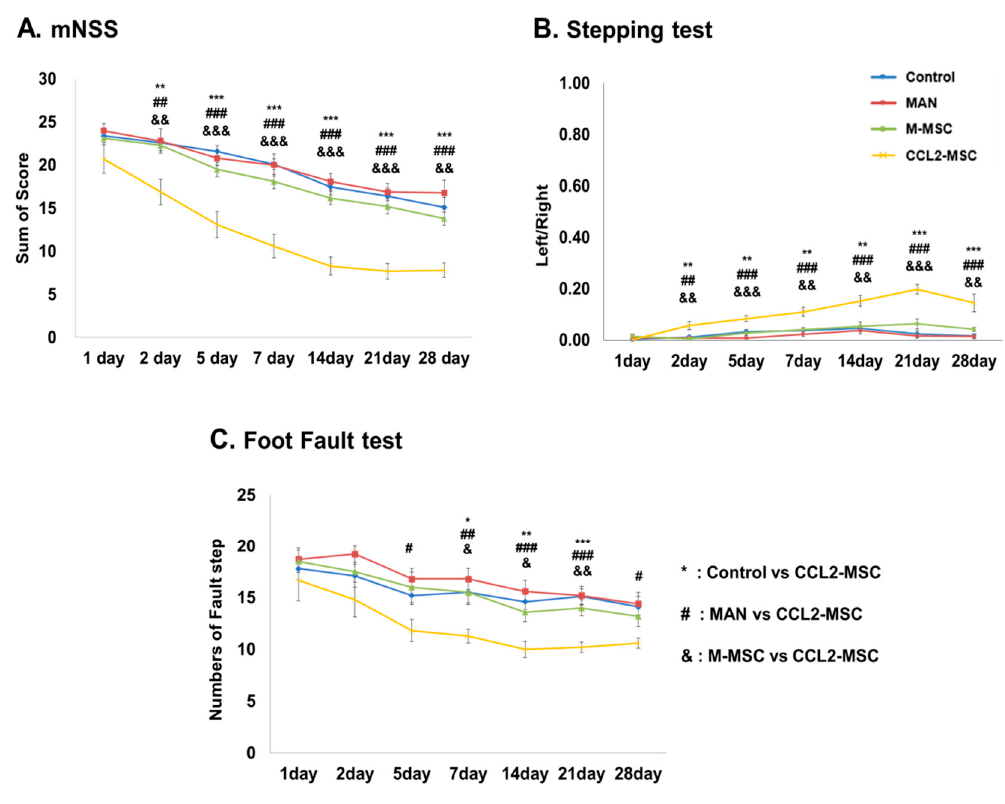
Figure 2. Evaluation of hUC-MSC transplantation according to behavioral testing. Changes in ( A ) mNSS, ( B ) stepping, and ( C ) foot-fault results for each group for up to 28 days after MCAo induction. Data represent the mean ± SEM and were analyzed by one-way ANOVA. * p < 0.05, ** p < 0.01, *** p < 0.001, control vs. CCL2-MSC; # p < 0.05, ## p < 0.01, ### p < 0.001, MAN vs. CCL2-MSC; & p < 0.05, && p < 0.01, &&& p < 0.001, M-MSC vs. CCL2-MSC.